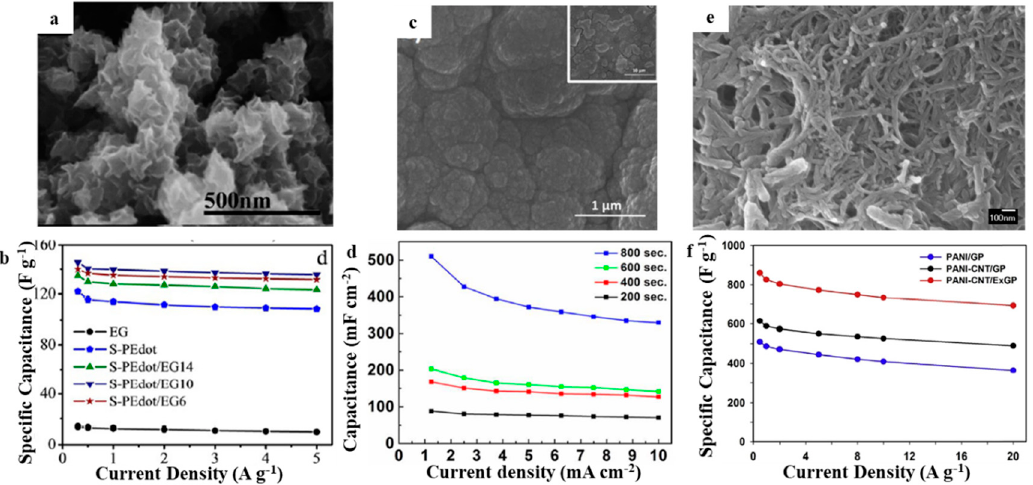
Figure 4. SEM of ( a ) S-PEdot/EG [47]; ( c ) EG–PPy [48]; ( e ) PANI-CNT/EG [50]; the specific capaci-